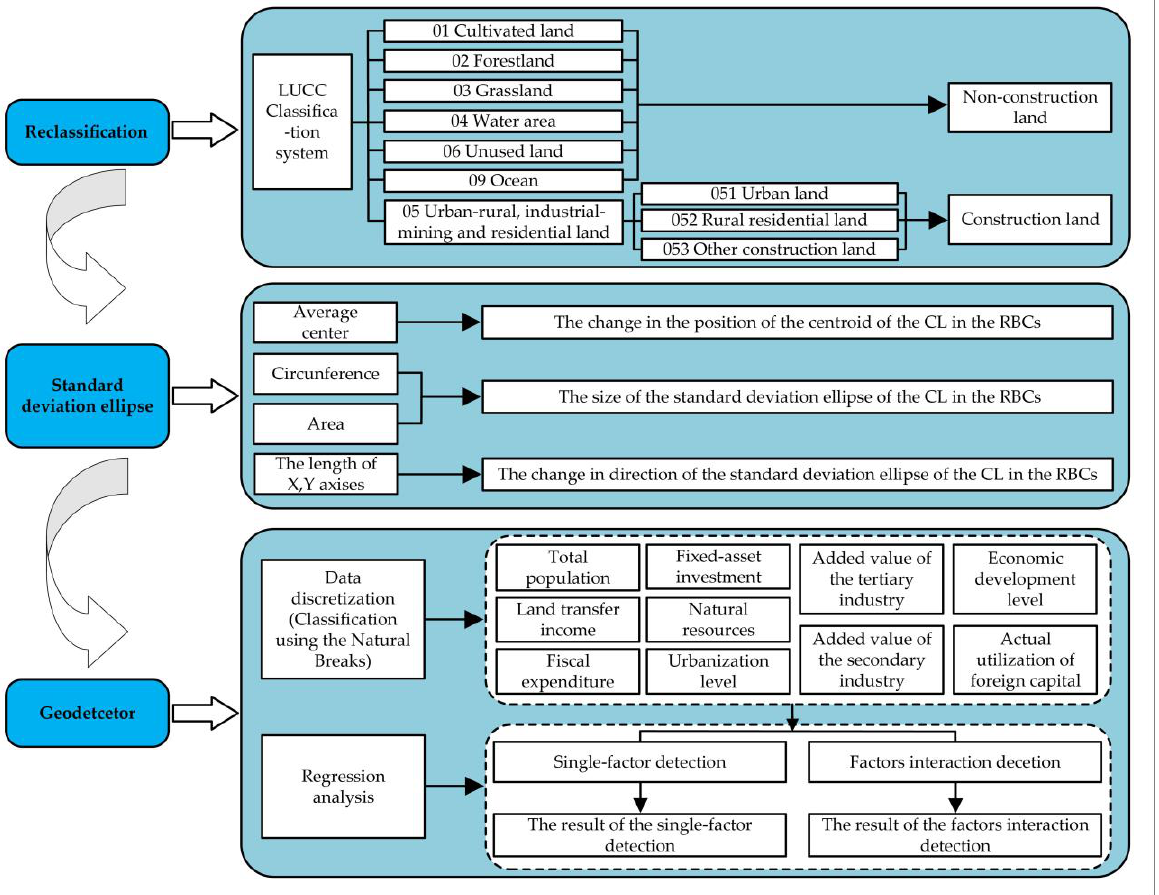
Figure 2. The flowchart of methods.